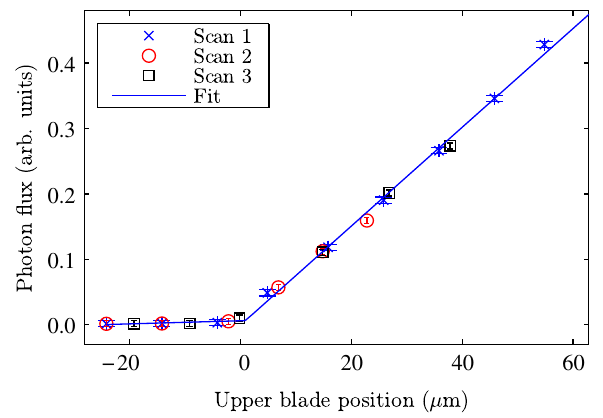
FIG. 3. Measured photon flux passing white-beam slits, at a photon energy of 2015 eV, for different positions of the upper blade. The pinhole aperture was measured by closing the upper blade until the photon flux passing the pinhole was minimized. For negative positions of the upper blade, the upper and lower blades are crossed, and (ideally) no photon flux passes. A pinhole height of 5 (cid:2) 5 μ m was